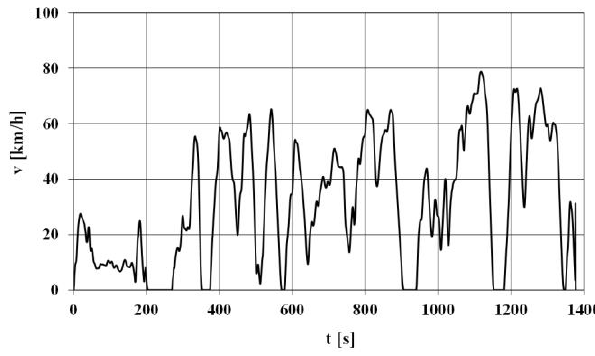
Fig. 3. The process of vehicle velocity in the Malta test During the Fig. 4 and 5 present the engine speed and relative